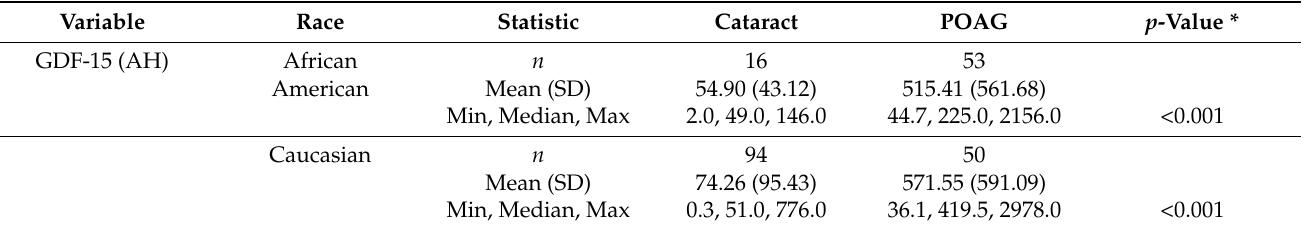
Table 2. GDF15 levels in the aqueous humor of Caucasian and African American POAG and cataract